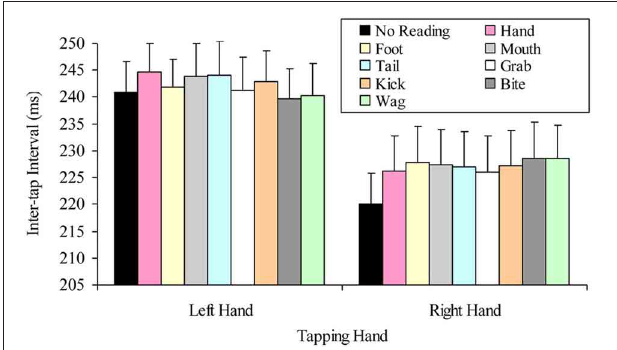
FIGURE 2 | Mean inter-tap intervals of each hand while reading the different words (error bars represent the standard error of the mean).